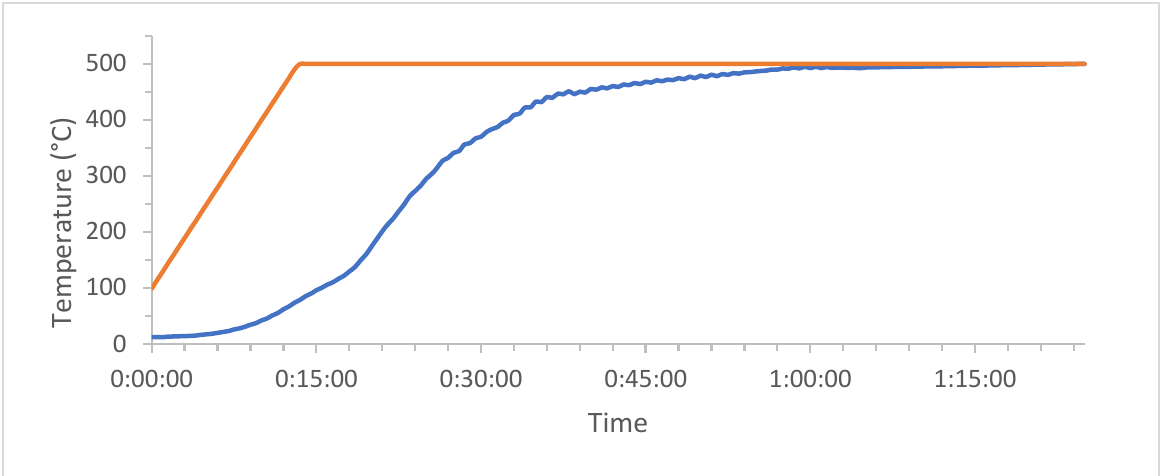
Figure 3. Temperature curve of the pyrolysis process (orange—temperature in furnace; blue—temperature in reactor).